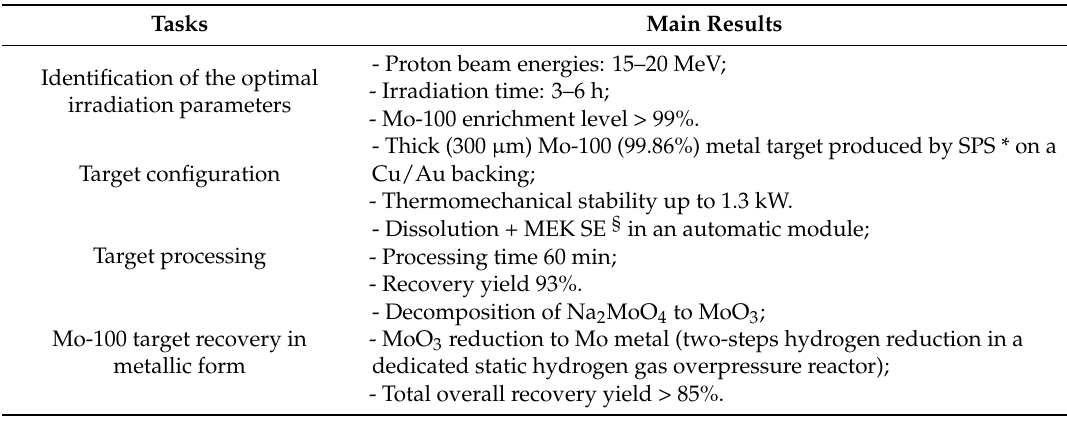
Table 3. Summary of the main results achieved within the APOTEMA and TECHN-OSP projects [18–26,32]. * SPS = Spark Plasma Sintering; § MEK SE = Solvent Extraction with Methyl Ethyl